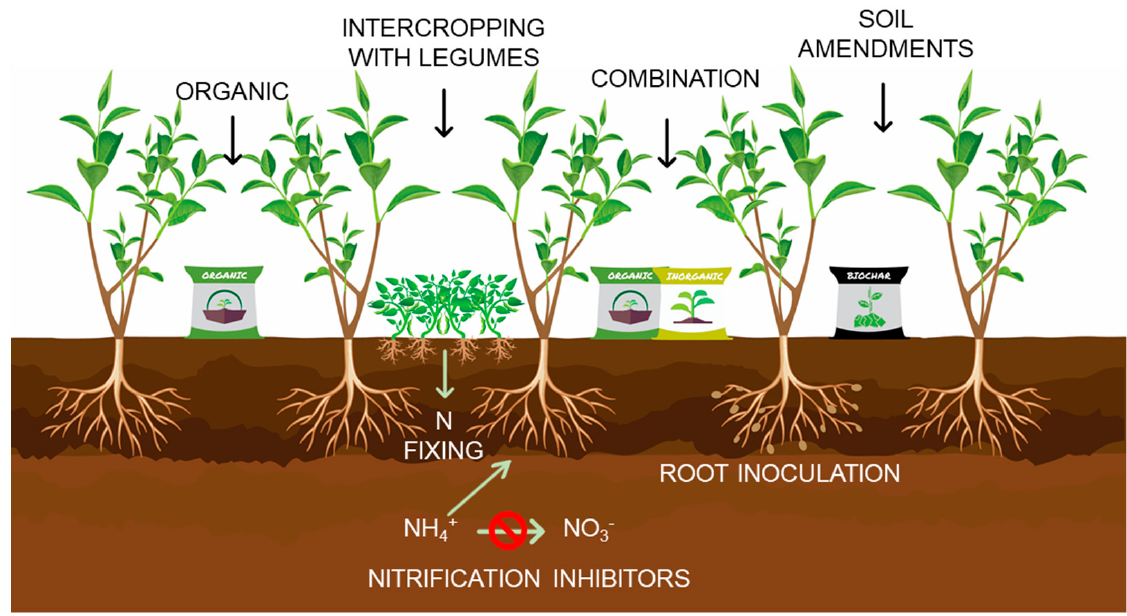
Figure 3. Integrating alternative nitrogen management practices for tea plantations.